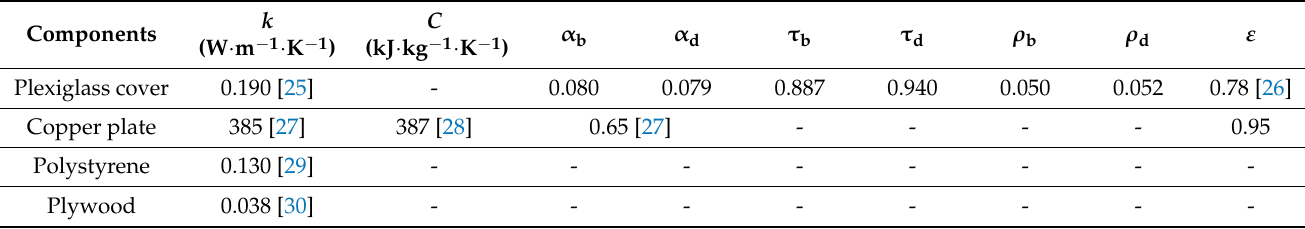
Table 1. Properties of materials used for construction of the solar drying